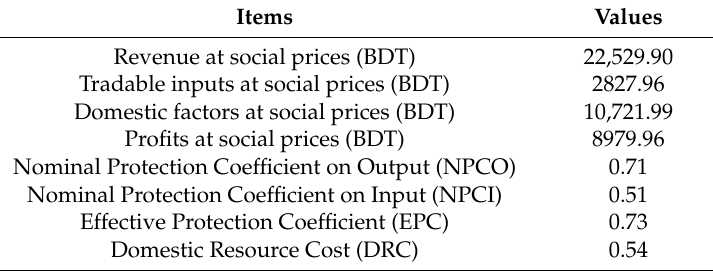
Table 2. Competitiveness of